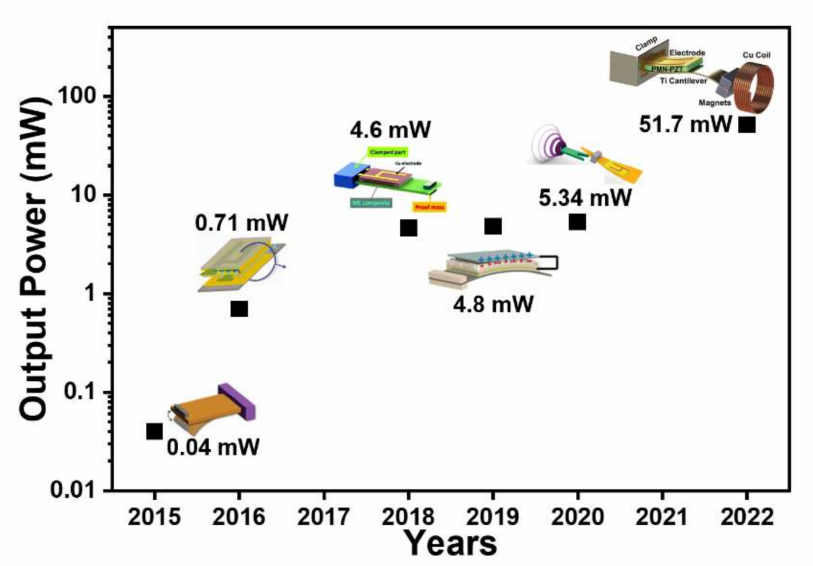
Figure 12. Summary on the output power of MME composite generators since 2015. Copyright